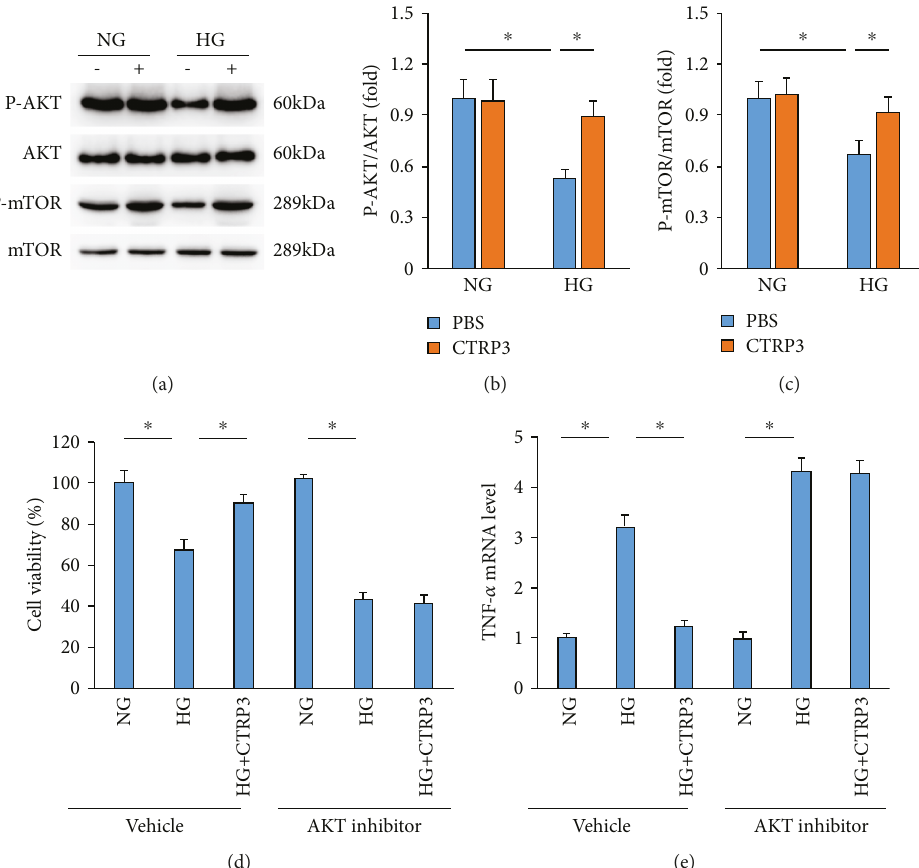
Figure 4: CTRP3 activated the AKT signaling pathway. (a – c) The protein expression of AKT and mTOR was detected by western blot analysis ( n = 5 ). (d) Cell viability in HUVECs induced by high glucose ( n = 5 ). (e) The mRNA expression of TNF- α in HUVECs exposed to high glucose ( n = 5 ). Data are expressed as mean ± SD of fi ve independent experiments. ∗ P < 0 05 when compared to the matched control.